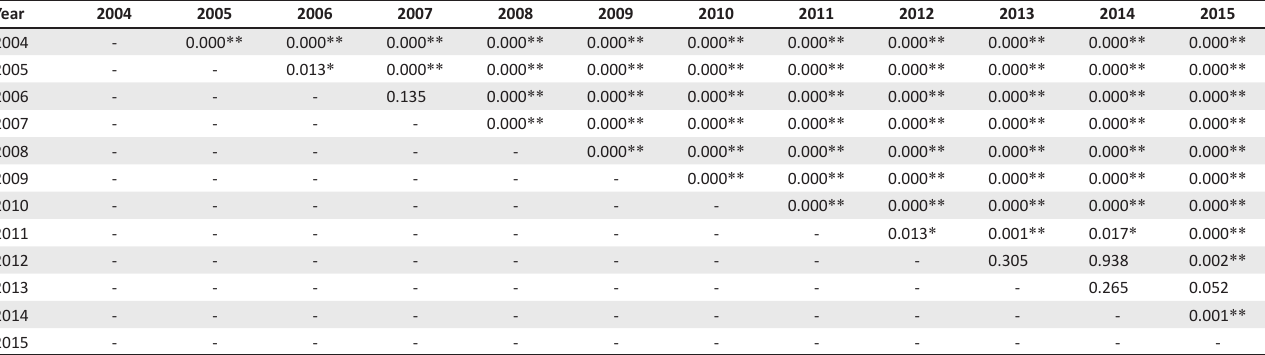
TABLE 7: Fisher’s least significant difference results for the mean total Broad-Based Black Economic Empowerment scores per annum.